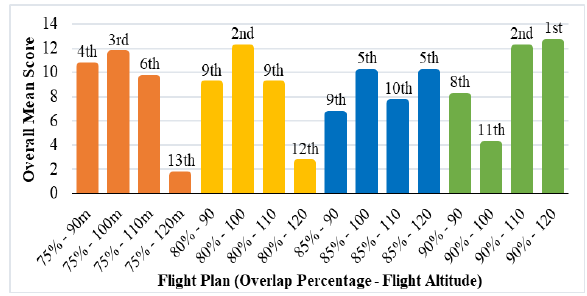
Figure 12 . Bar Graph for the visualization of flight plans based on the overall mean score and rank with respect to overlap percentage and flight altitude